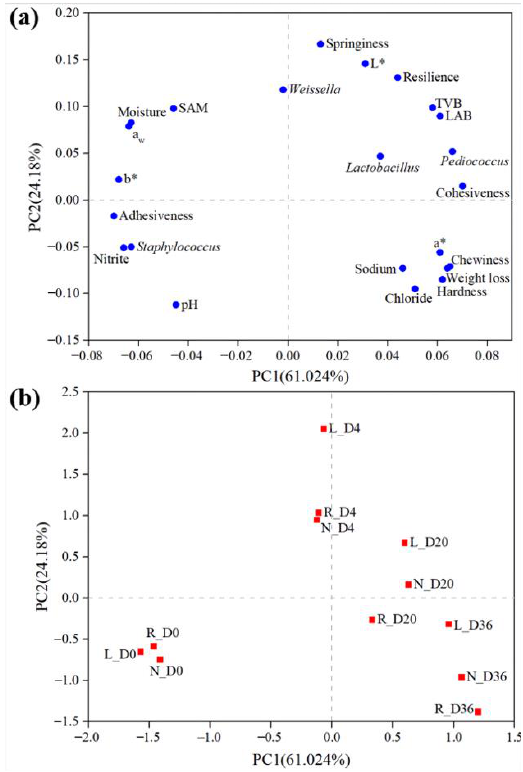
Figure 6. PCA plots of multiple parameters ( a ) and samples of the fermented sausages ( b ). The ● represents multiple parameters. TVB: total viable bacterial counts, SAM: Staphylococcus and Micrococcus counts. The ■ represents the samples. N: fermented sausages with 3% NaCl (reference), L: fermented sausages with 2.25% NaCl (25% reduction), R: fermented sausages with partial replacement of 25% NaCl. The marks D0, D4, D20 and D36 represent the fermentation and ripening times (days).